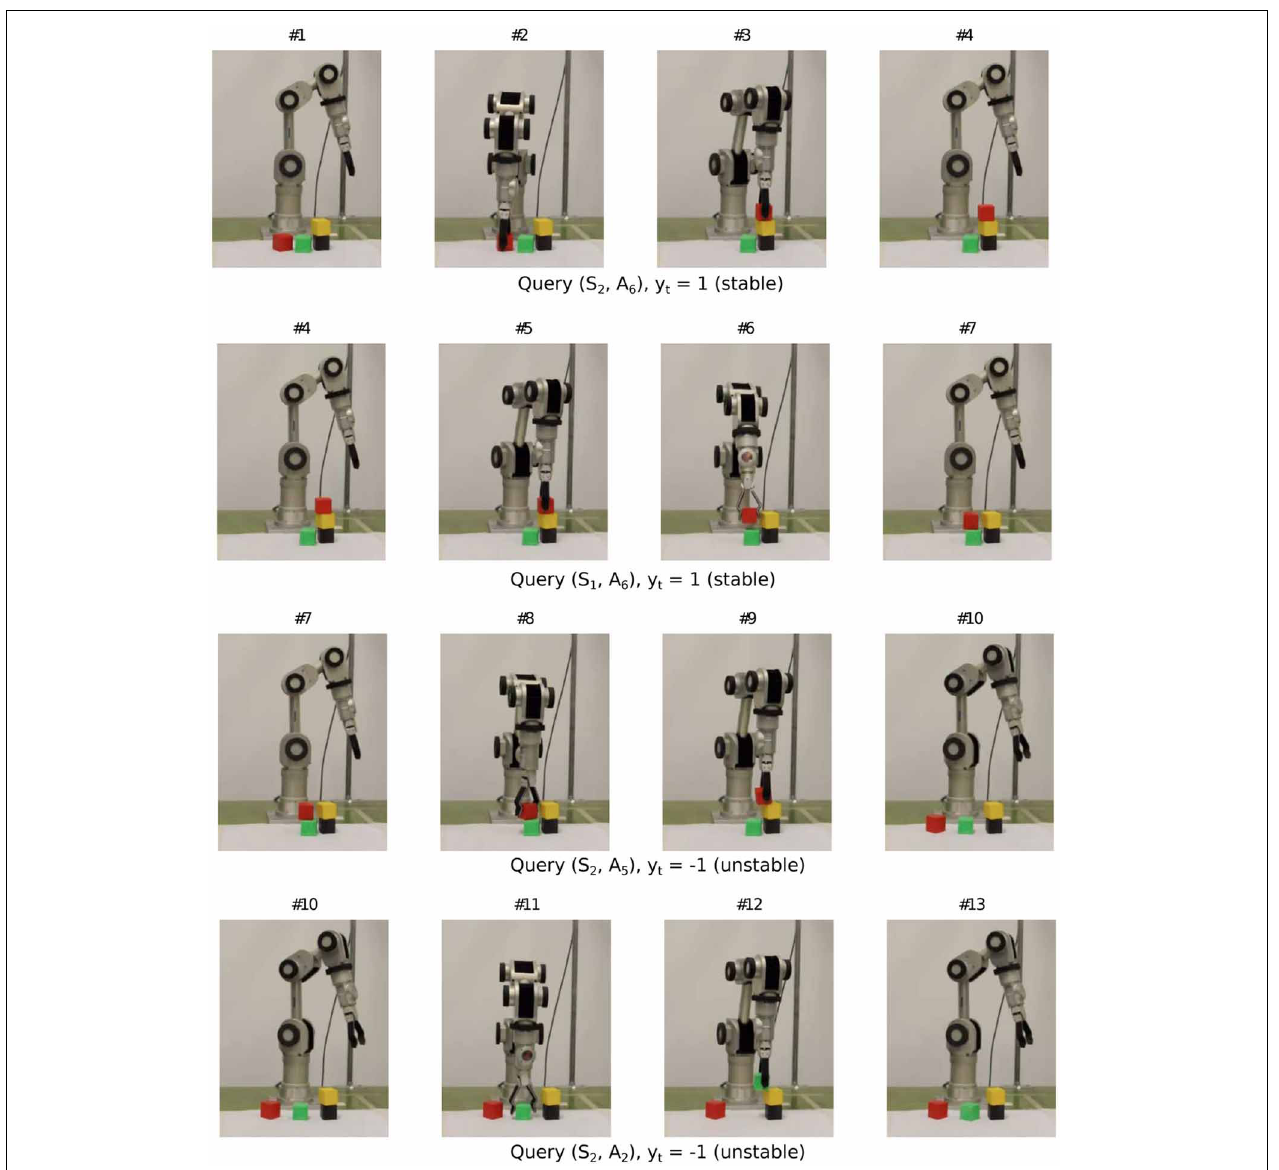
FIGURE 10 | Sample query sequence on real robot